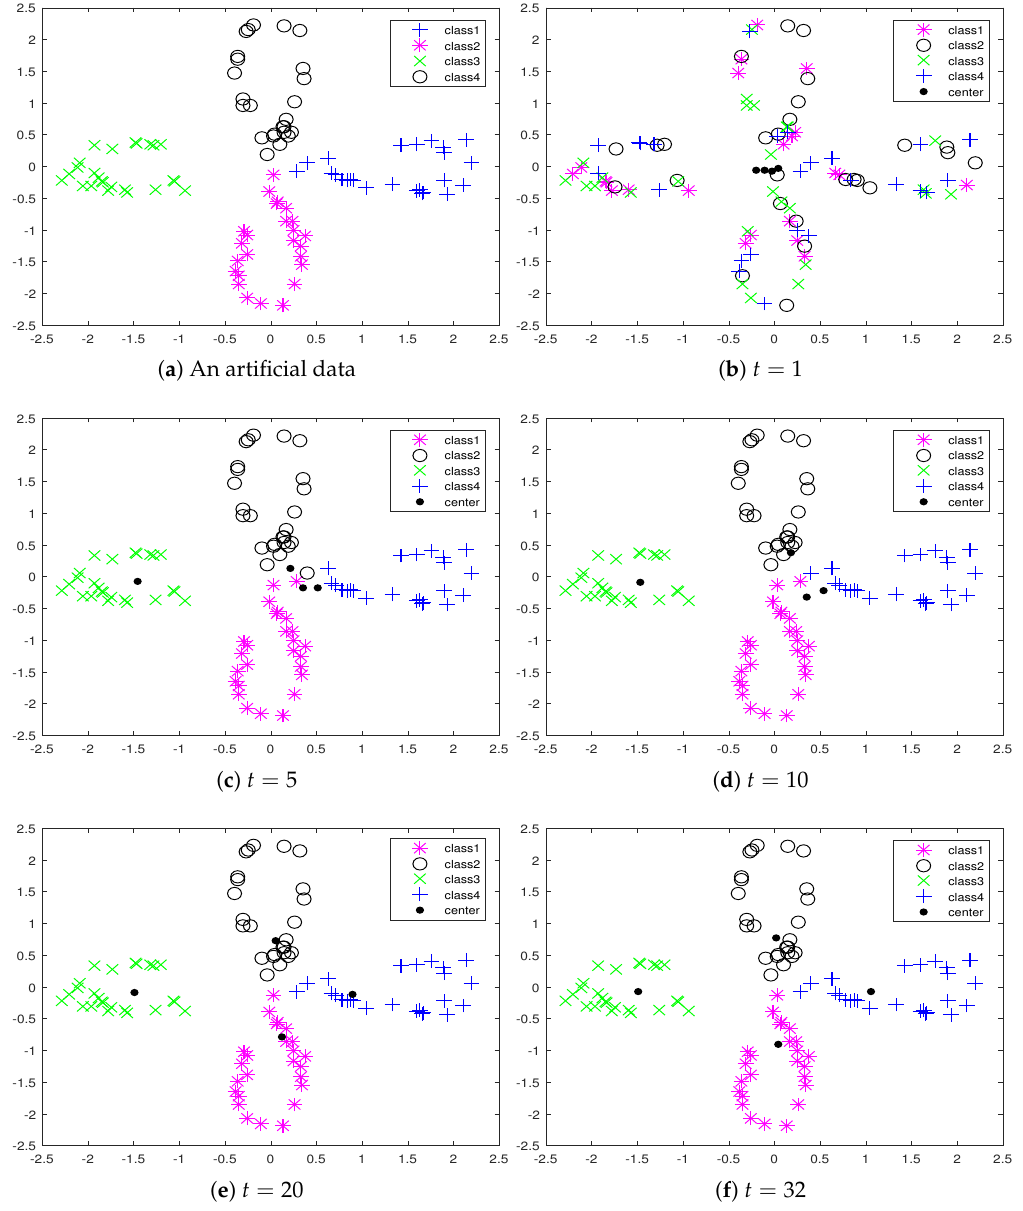
Figure 1. The demonstration figure of the clustering process for artificial data. ( a ) The original data. ( b – e ) The clustering figures when the number of iterations t = 1, 5, 10, 20, respectively. ( f ) The final clustering